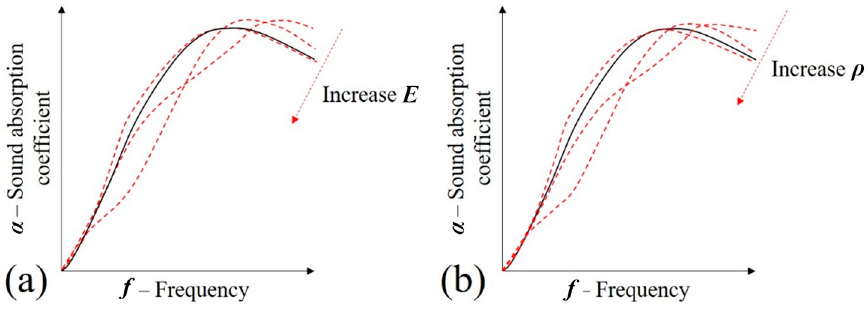
Figure 16. Influence of changing poroelasticity parameters in the sound absorption coefficient of a generic porous media: ( a ) E —elastic modulus and ( b ) ρ —density. generic porous media: ( a ) E —elastic modulus and ( b ) ρ —density.